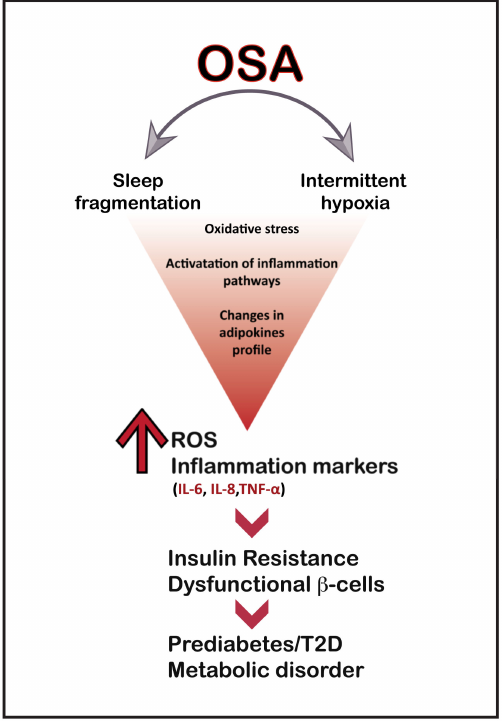
Figure 2. Potential mechanisms linking hypoxia to